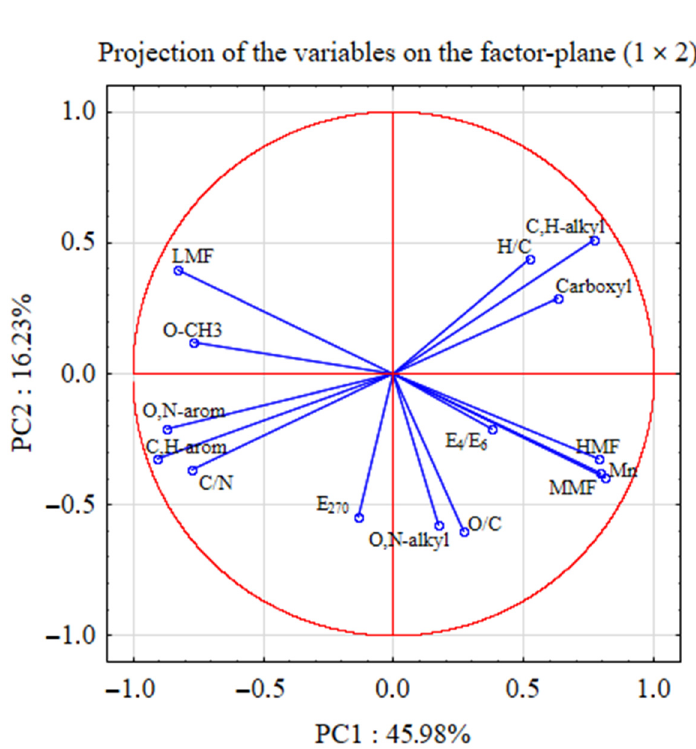
Figure 8. Projection of HA parameters using